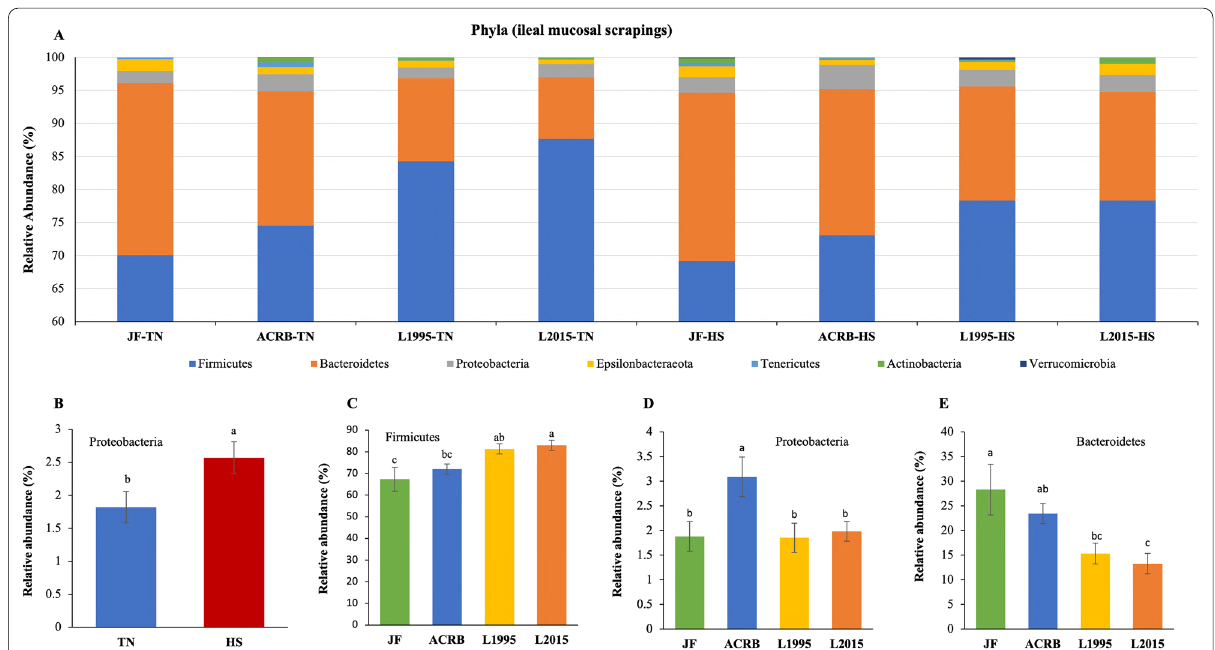
Fig. 9 Changes in relative bacterial abundance (%) in the ileal mucosal scrapings of Jungle Fowl (JF), Athens Canadian Random Bred (ACRB), 1995 Random Bred (L1995), and 2015 Modern Random Bred (L2015) chicken lines raised under thermoneutral (TN) or heat stress (HS) condition (8 h/d; 36 °C) on d 56 at phylum level. A Taxonomic profile of ileal content microbiota. B Effect of ambient temperature on the relative abundance of Proteobacteria. Effect of genetic line on relative abundance of C Firmicutes, D Proteobacteria, and E Bacteroidetes. Different letters